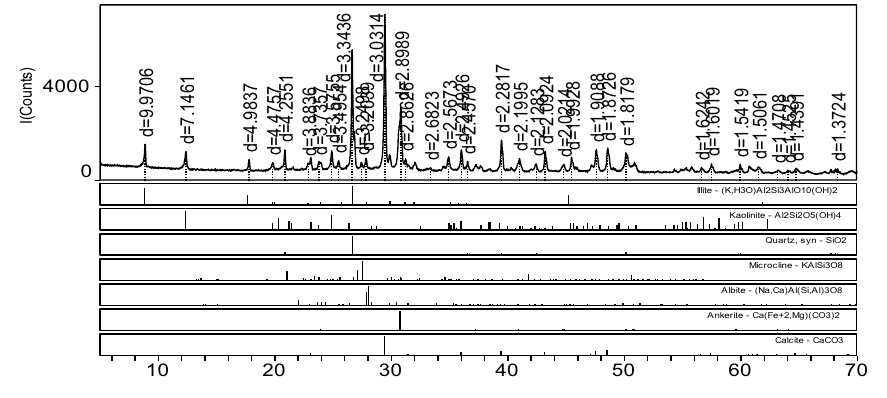
Figure 21. XRD pattern of the rock sample.